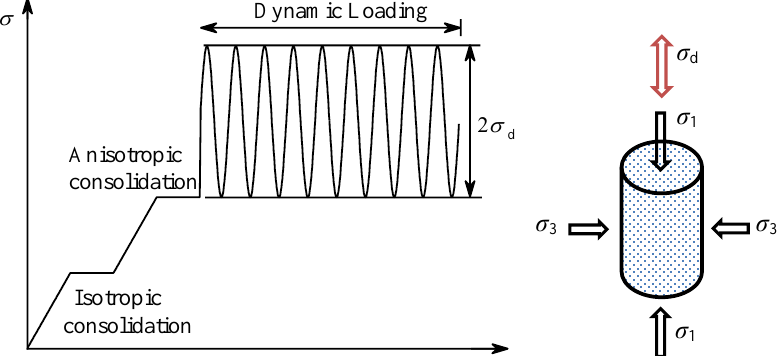
Figure 2. Schematic of the loading process.